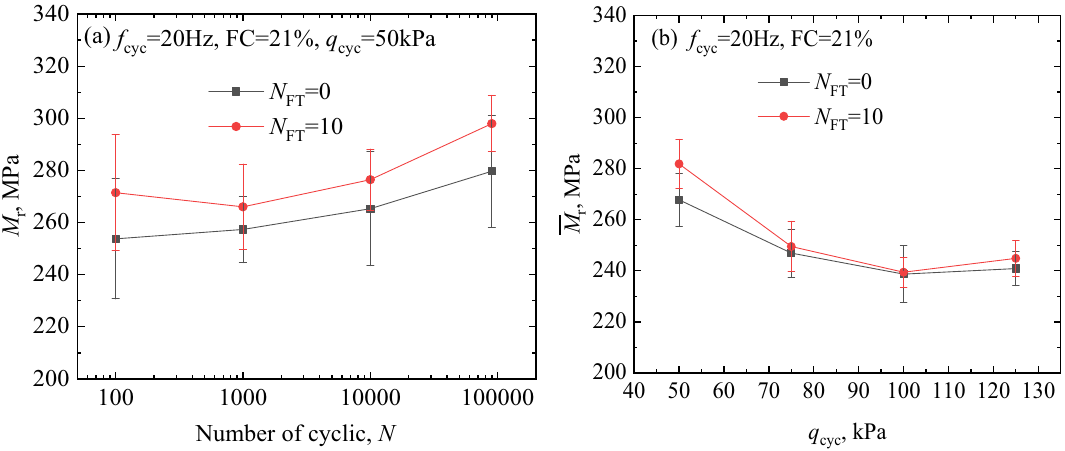
Figure 6. Relationship between M r and N , q cyc : focusing on N FT : ( a ) focusing on the effect of N and ( b ) focusing on q cyc .